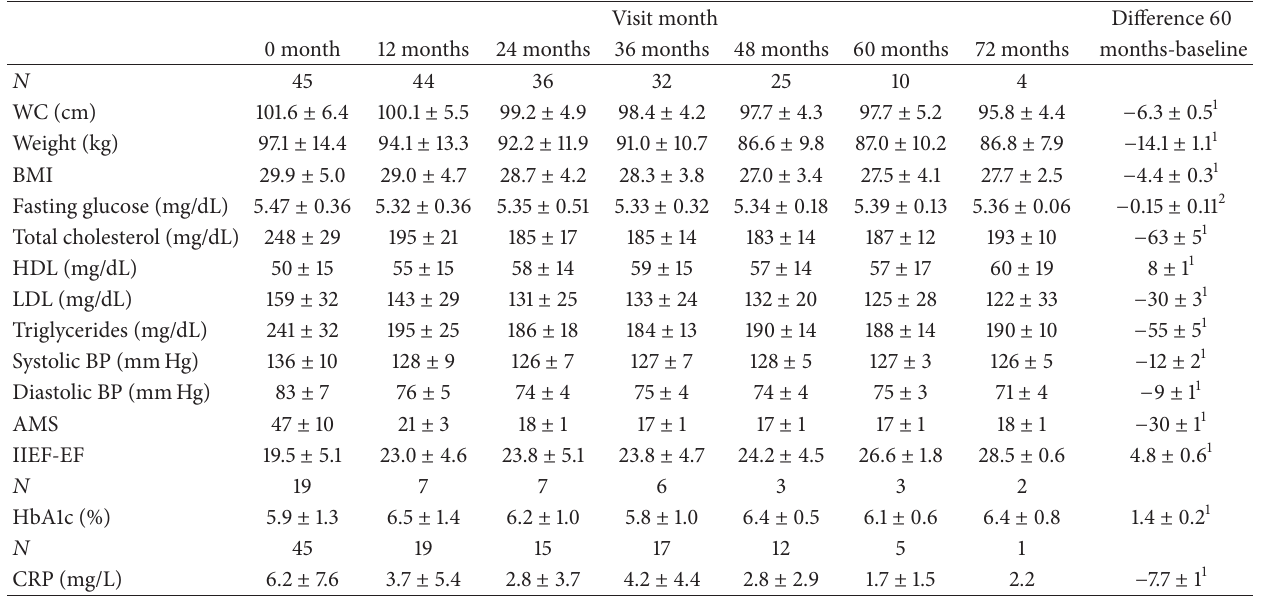
Table 5: Effects of testosterone on metabolic variables (means ±